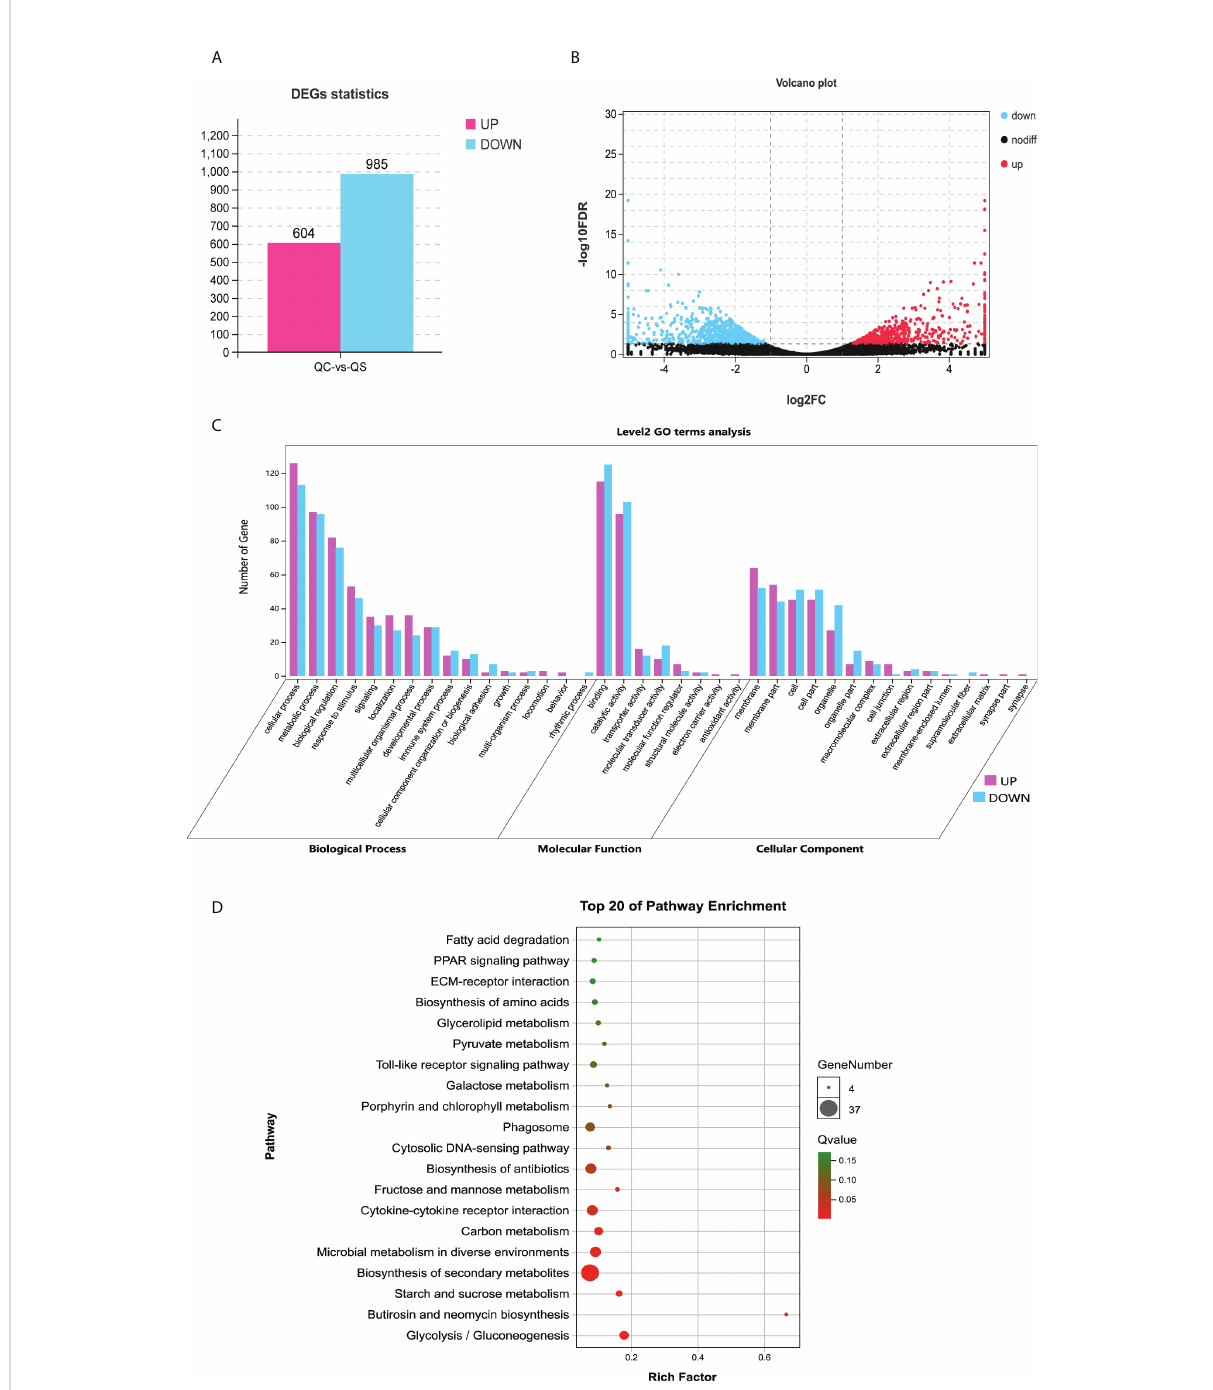
FIGURE 3 Identi fi cationandfunctionalannotationofdifferentiallyexpressedgenes. (A) Histogramshowsdifferentiallyexpressedgenes.Blueandredindicatedecreased andincreasedexpression,respectively. (B) Volcanomapshowsdifferentiallyexpressedgenes.Theabscissarepresentsthefoldchangevaluesofsamplesin controlgroup/samplesinfectedby V.parahaemolyticus